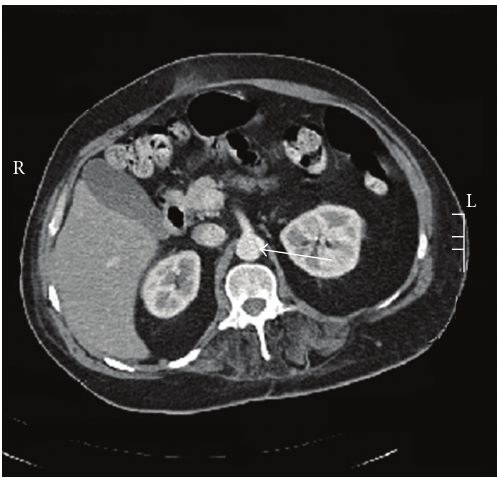
Figure 3: Post-op contrast CT abdomen showing supraceliac aortic dissection (white